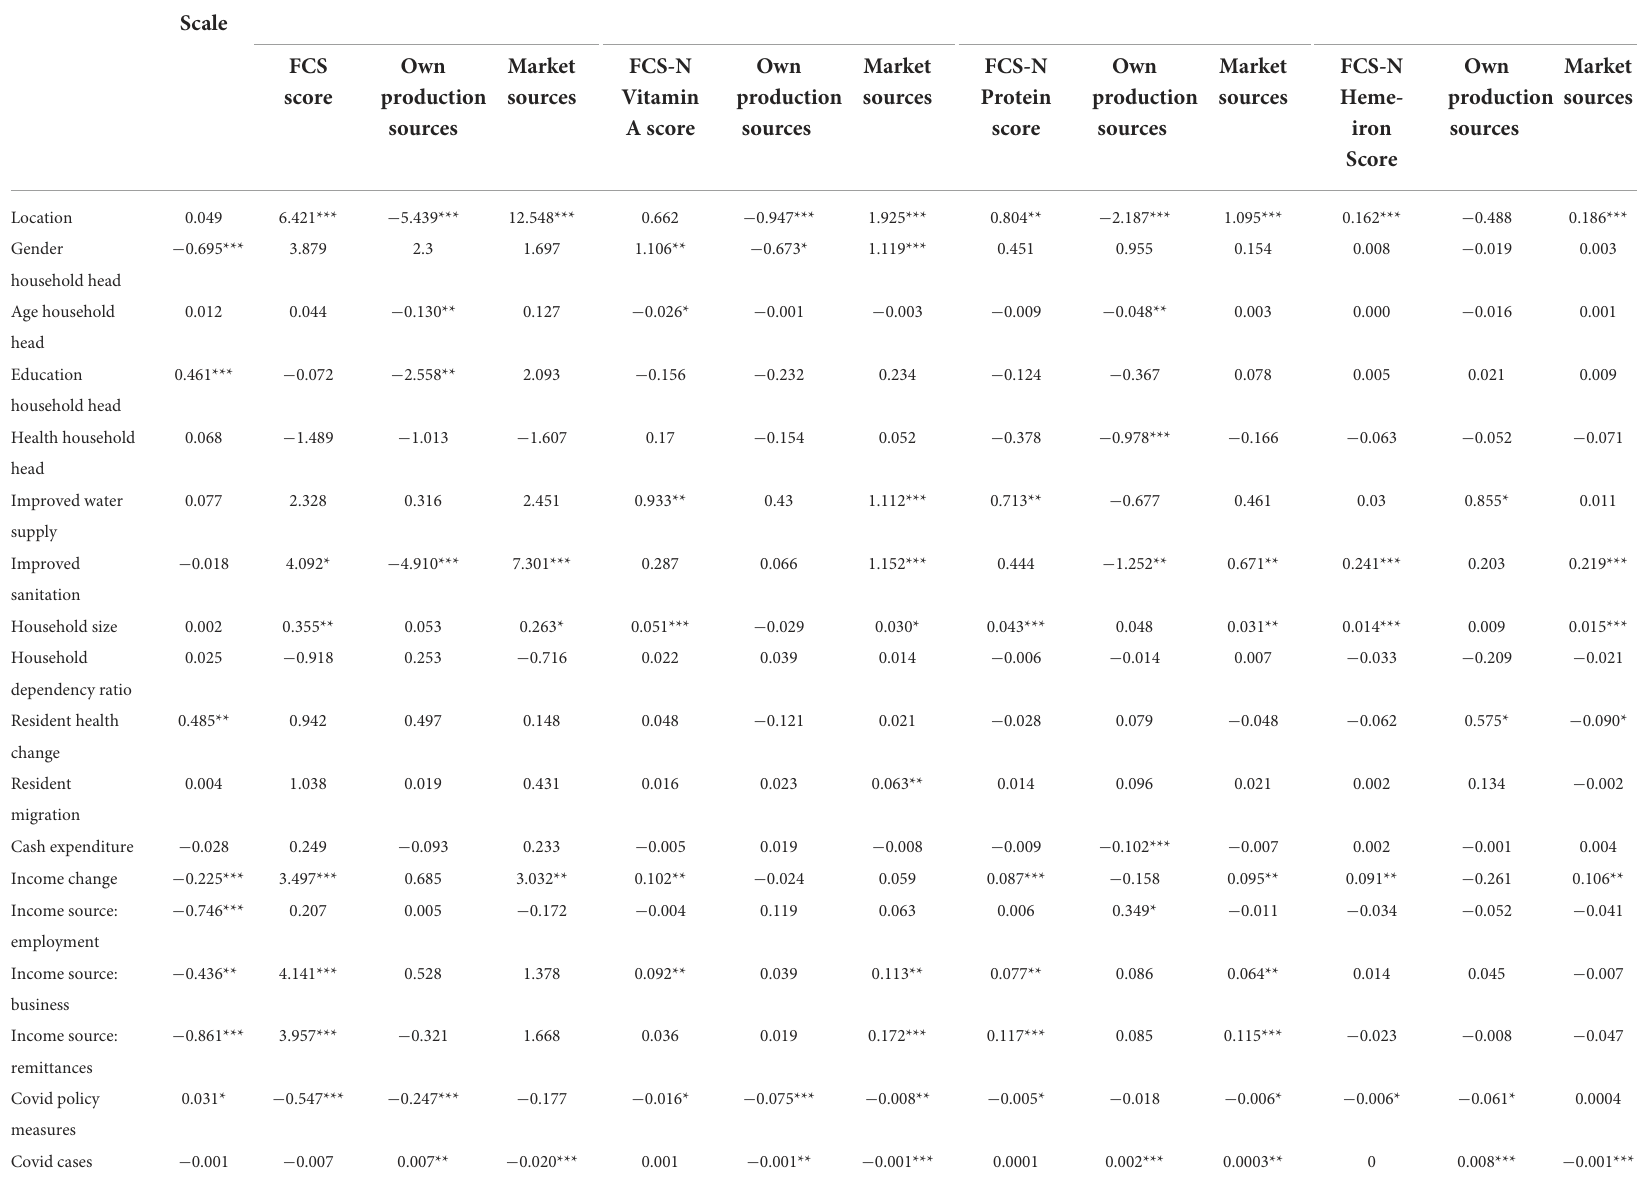
TABLE 9 Regression model